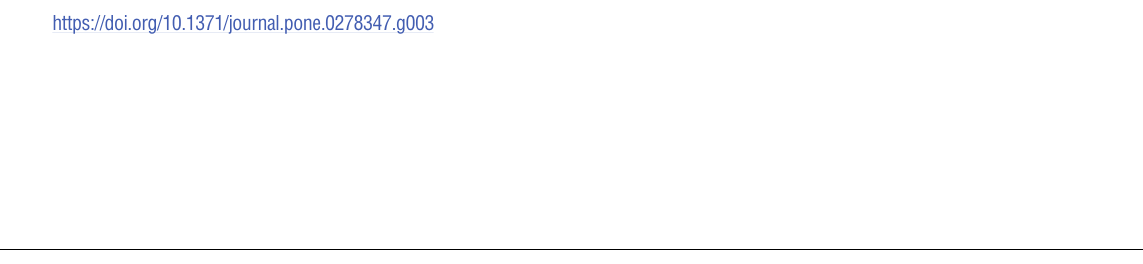
PLOS ONE | https://doi.org/10.1371/journal.pone.0278347 November29, 2022 9 /